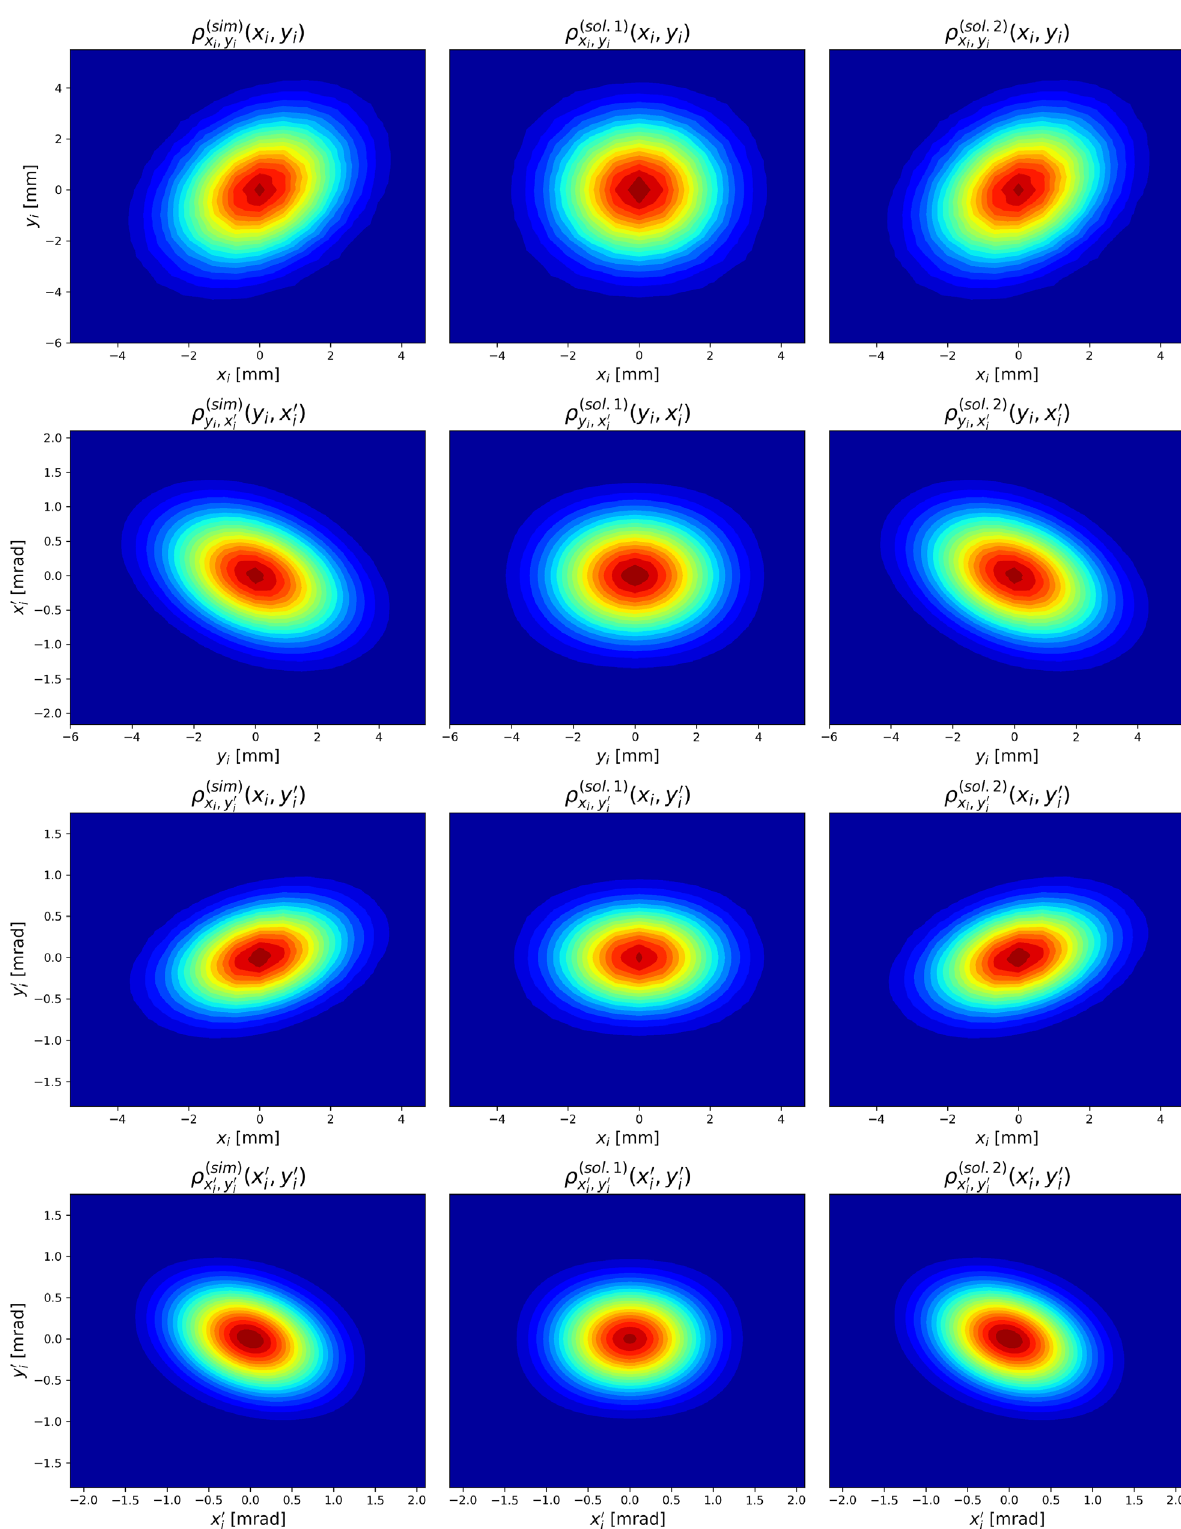
FIG. 5. Four cross-plane 2D projections of the transverse phase space distribution for (i) the simulated distribution (left column), (ii) the two-scan analytical solution (middle column), and (iii) the four-scan numerical solution (right